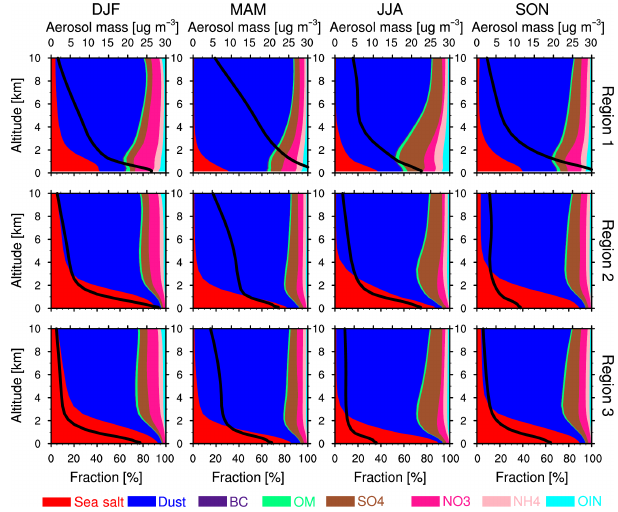
Figure 14. Vertical distributions of seasonal mean aerosol mass (black solid line; upper x axis) and its composition fraction (col- ored shade-contour; lower x axis) from the WRF-Chem simulation averaged for the period 2010–2014 over three sub-regions as shown in Fig.